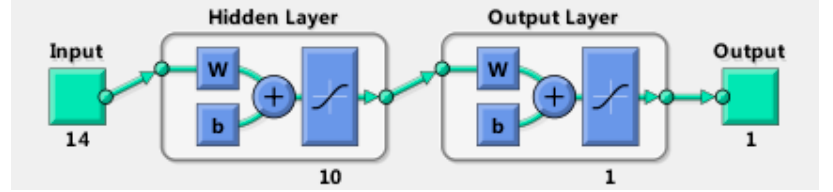
Figure 6. The construction of the improved backpropagation (BP) neural network model.